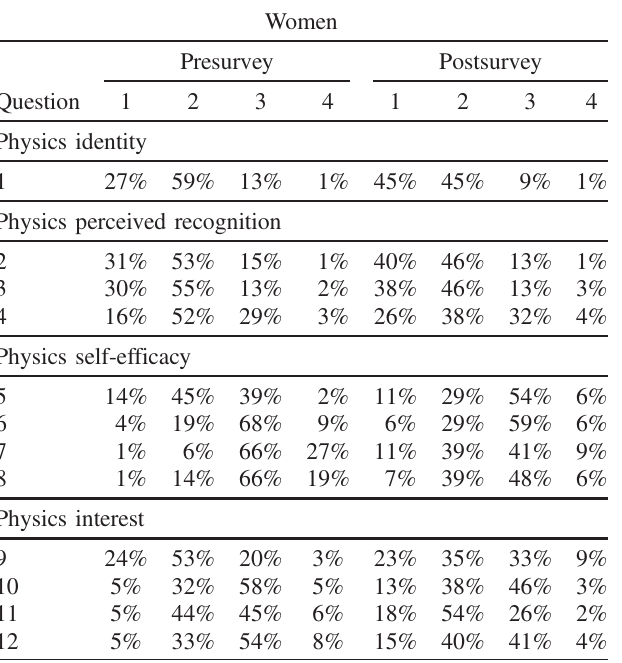
TABLE VIII. Percentages of 260 women in physics 1 who answered each question by the options they selected with 1 being the low value (NO! and strongly disagree) and 4 being the high values (YES! and strongly agree). The rating scale for the self- efficacy and interest questions was NO!, no, yes, YES! while the rating scale for the physics identity and perceived recognition questions was strongly disagree, disagree, agree, strongly agree.